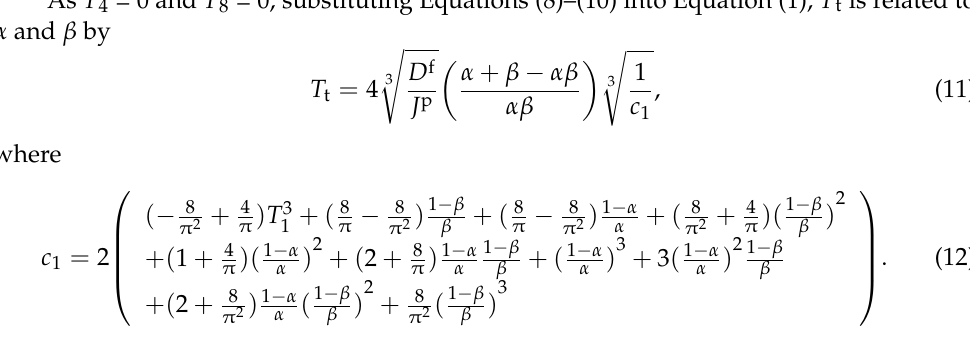
Figure 2. Jerk curves with different α and β .